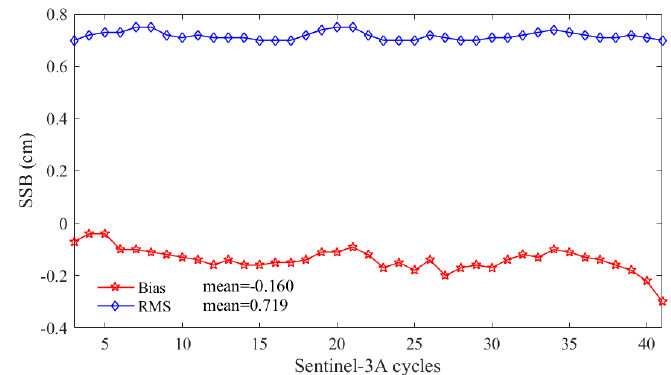
Figure 9. Cycle by cycle biases and RMSEs of differences of SSB correction between SAR and PLRM mode.